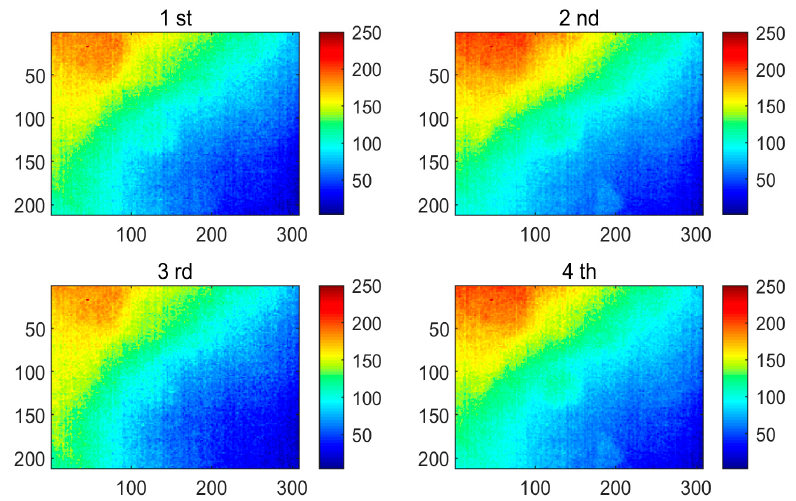
Figure 10. Several simulated SNGAN thermograms of the CFRP specimen 1.